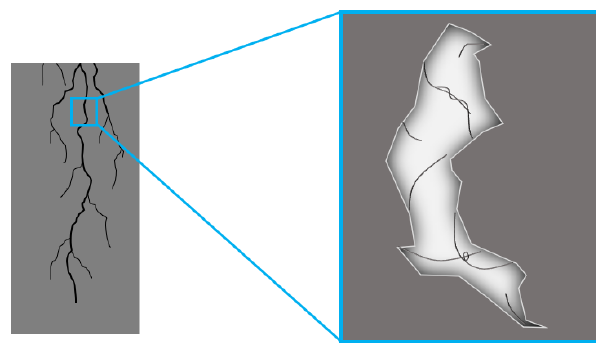
Figure 5: Bridging Mechanism of